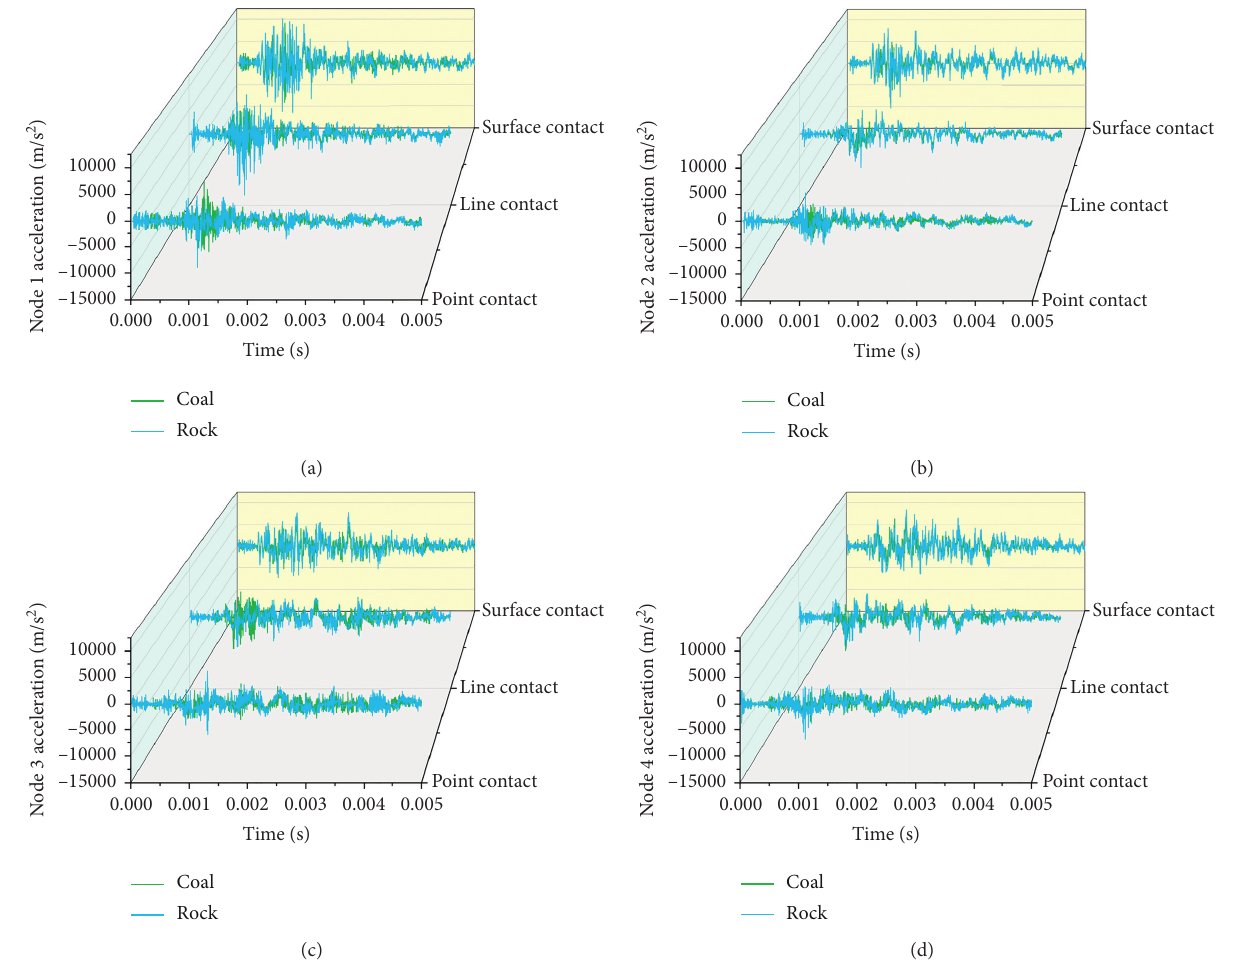
Figure 19: Nodal acceleration in the tail beam noncollision contact zone under different contact modes: (a) Node 1 acceleration; (b) Node 2 acceleration; (c) Node 3 acceleration; (d) Node 4 acceleration.